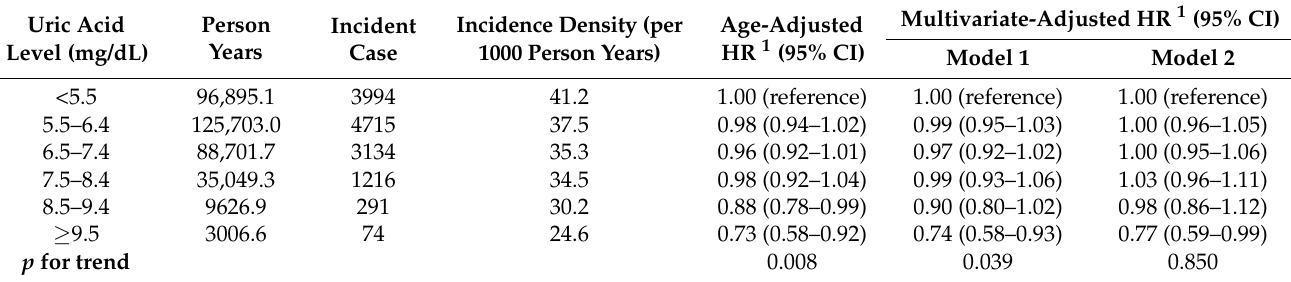
Table 2. Hazard ratios 1 (95% CI) of LUTS (>8) by uric acid